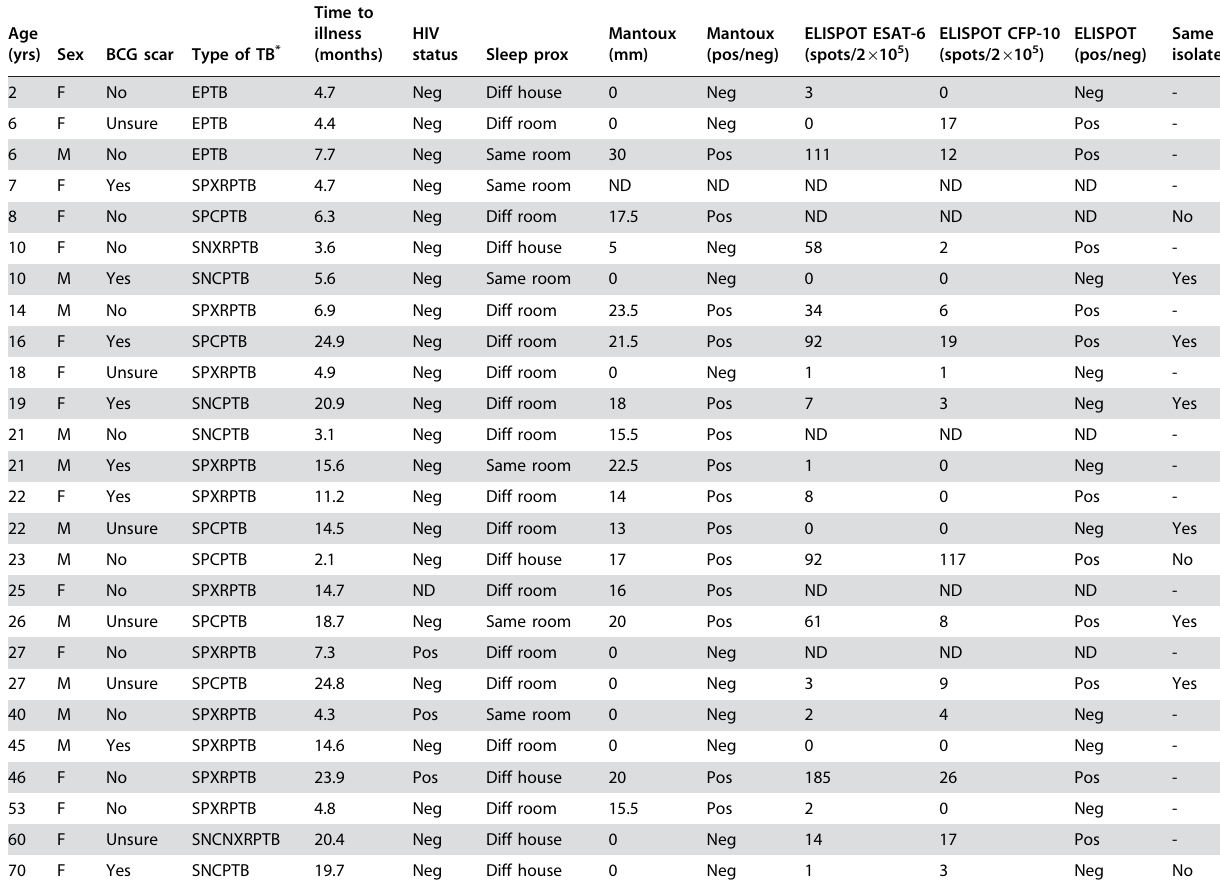
Table 2. Characteristics and type of TB in secondary cases, their recruitment Mantoux and ELISPOT results and details of the molecular genotyping results of index case and secondary case isolates if available. .. ... .... ... ... .... ... ... .... ... ... .... ... ... .... ... ... .... ... ... .... ... ... .... ... ... .... ... ... .... ... ... .... ... ... .... ... ... .... ... ... .... ... ... . Age (yrs) Sex BCG scar Type of TB *